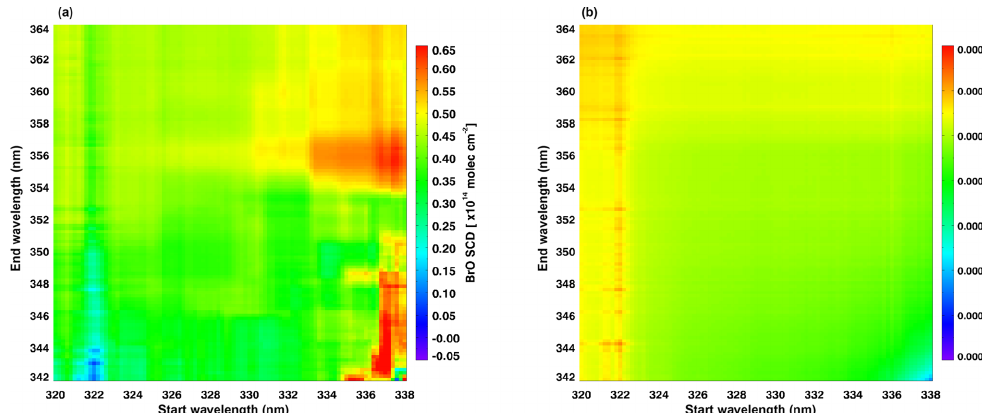
Figure 4. As Fig. 2 but for the Rann of Kutch salt marsh.